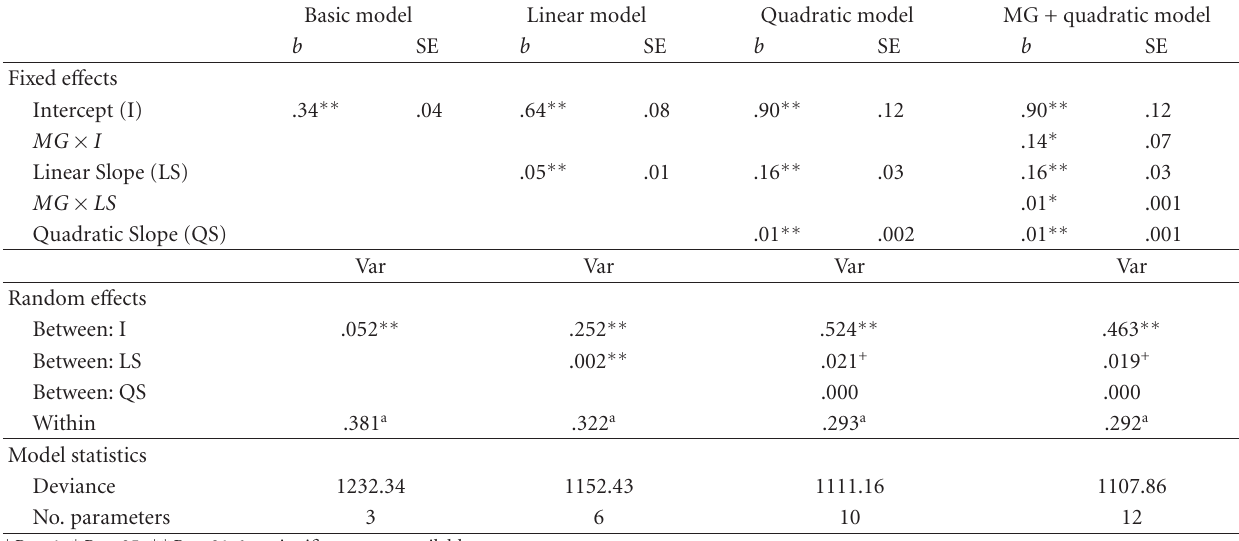
Table 5: Analysis of change in monitoring strategies prior to test